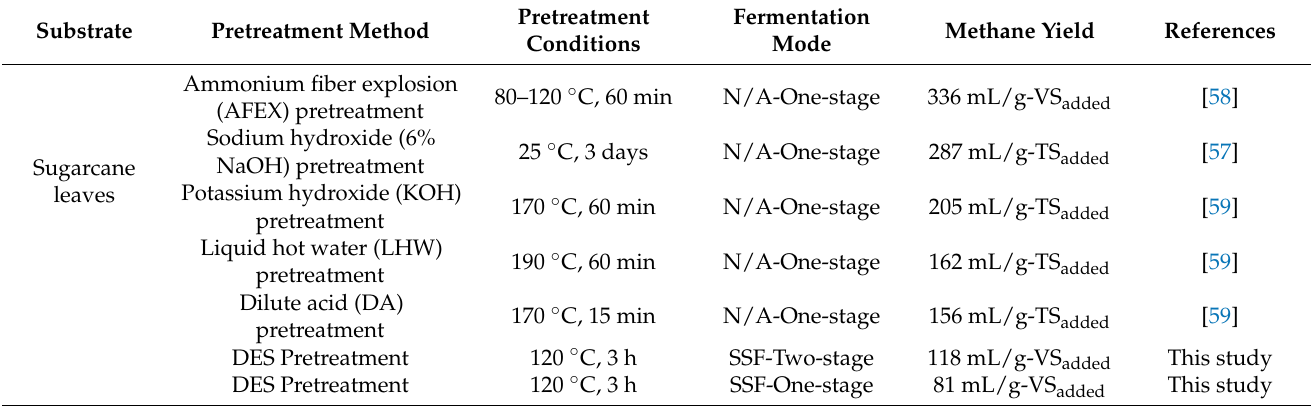
Table 8. The comparison between the methane yield obtained in this study with the literature searches using pretreated sugarcane leaves as the